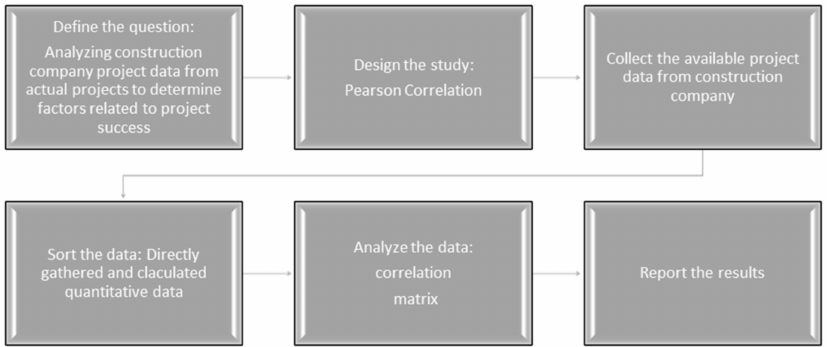
Figure 1. Overview of the